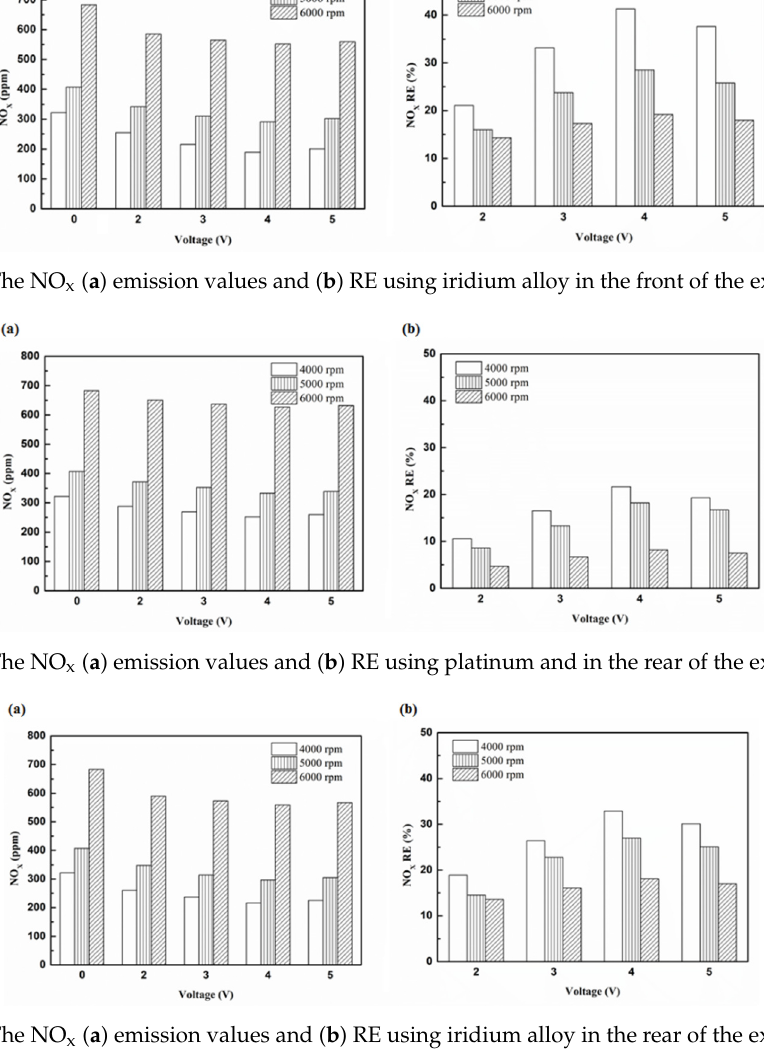
Figure 31. The NO x ( a ) emission values and ( b ) RE using iridium alloy in the rear of the exhaust pipe.